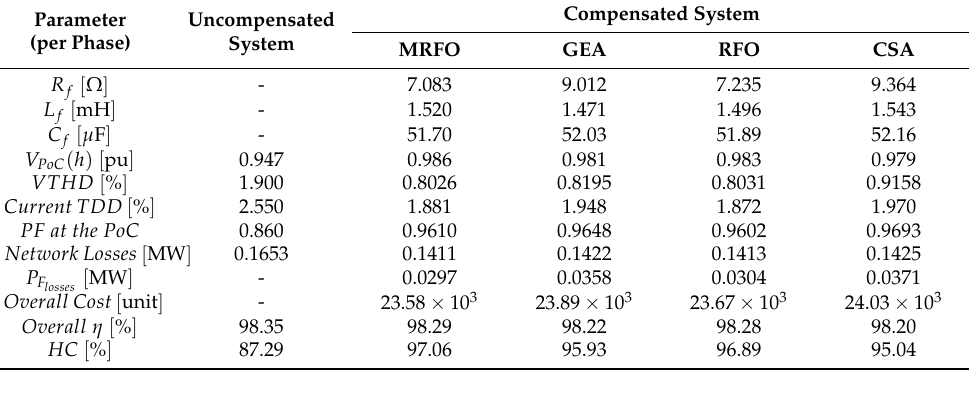
Table 4. Comparison of the different solutions proposed by the novel algorithms. Parameter (per